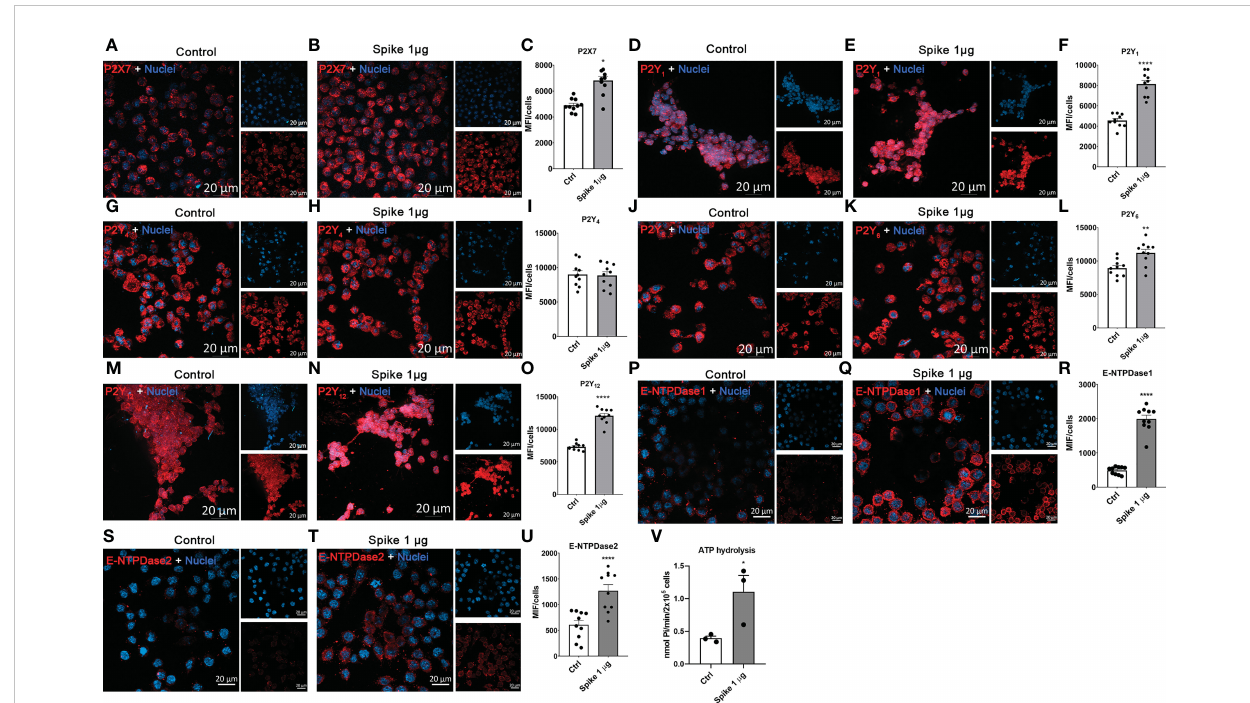
FIGURE 2 SARS − CoV − 2 spike protein increases the expression of P2 receptors and ectonucleotidases in microglial cells. BV-2 cells were left untreated (Ctrl) or stimulated with 1 µg/mL SARS − CoV − 2 spike protein for 24 h. Representative images and quantitative analysis for (A – C) P2X7, (D – F) P2Y 1 , (G – I) P2Y 4 , (J – L) P2Y 6 , (M – O) P2Y 12 , E-NTPDase1 (P – R) , and E-NTPDase2 (S – U) . Data are representative of three independent experiments (n=3) and expressed as mean ± SEM of 10 fi elds per condition. (V) ATP hydrolysis assay. Data are representative of three independent experiments (n=3) and expressed as mean ± SEM. Statistically signi fi cant differences between Ctrl and treated groups are represented by asterisks (*p < 0.05; **p < 0.01; ****p < 0.0001). Student ’ s t-test. Scale bars: 20 m